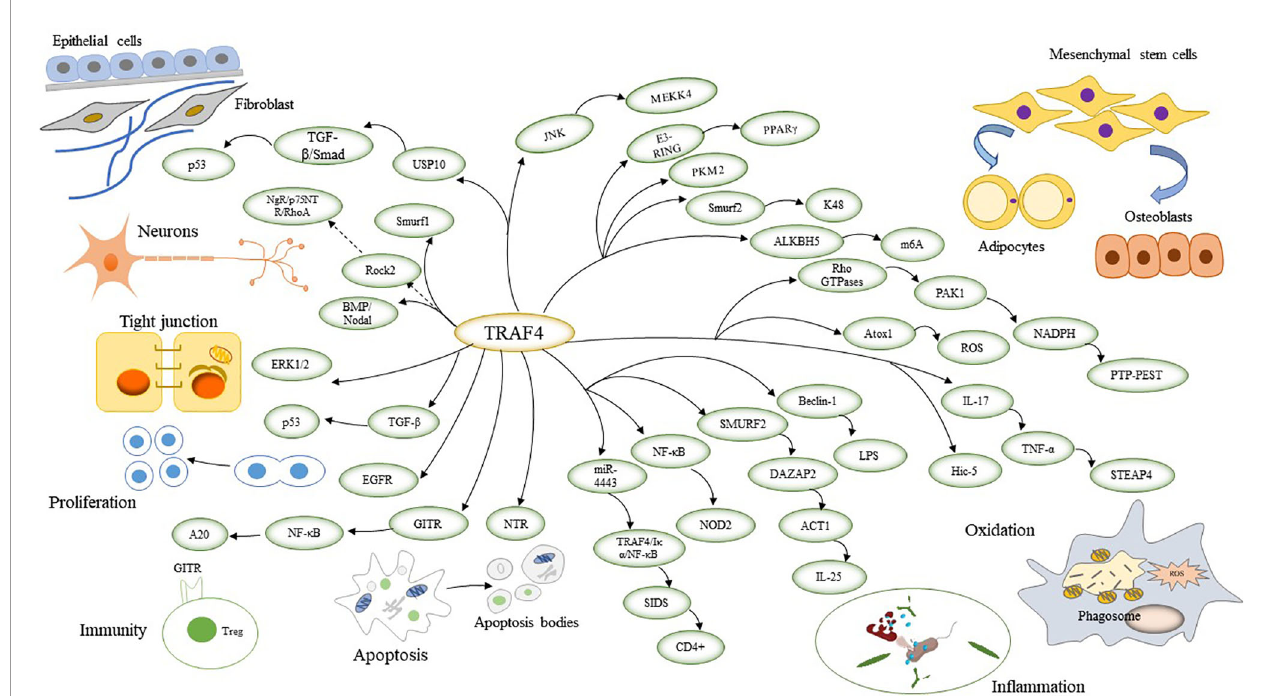
FIGURE 1 | TRAF4 involves signalling pathways that link physiological functions by connecting to reciprocal genes. TRAF4 regulates neuronal cell formation and affects cell polarity by regulating tight junctions. TRAF4 also promotes cell proliferation and cell in fl ammation and inhibits apoptosis. TRAF4 affects cellular oxidation by inducing ROS. TRAF4 regulates the differentiation of mesenchymal stem cells into adipocytes and osteoblasts, thereby impacting adipose bone production and metabolism. TRAF4 promotes cellular repair by affecting fi